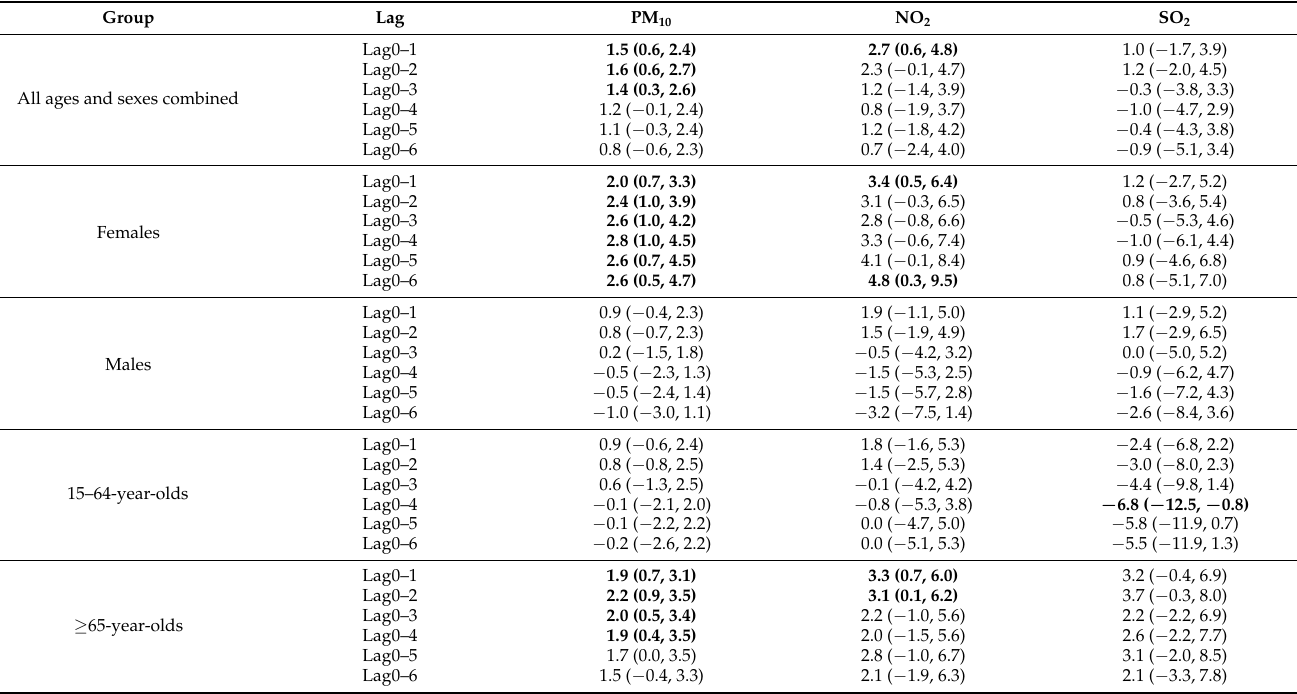
Table 5. One-pollutant model results for the percentage change (95% CI) in daily